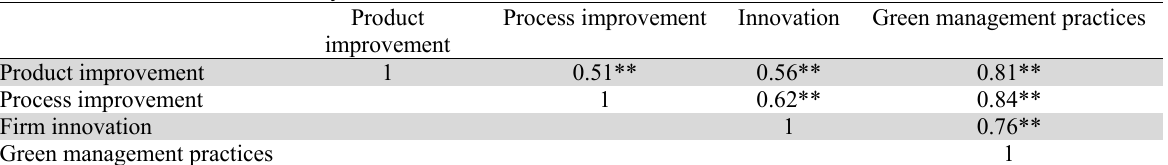
The correlation between survey items